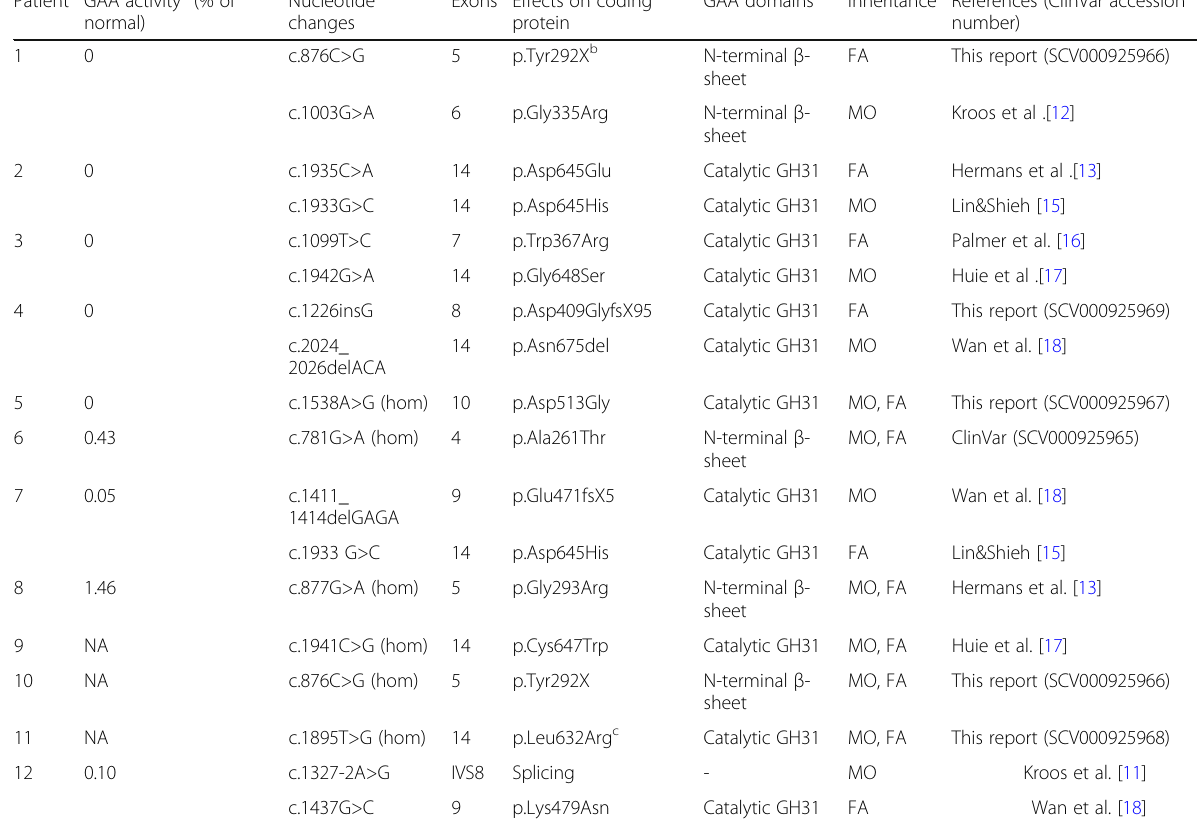
Table 3 GAA enzyme activity and mutations of 12 patients with IOPD Patient GAA activity a (% of